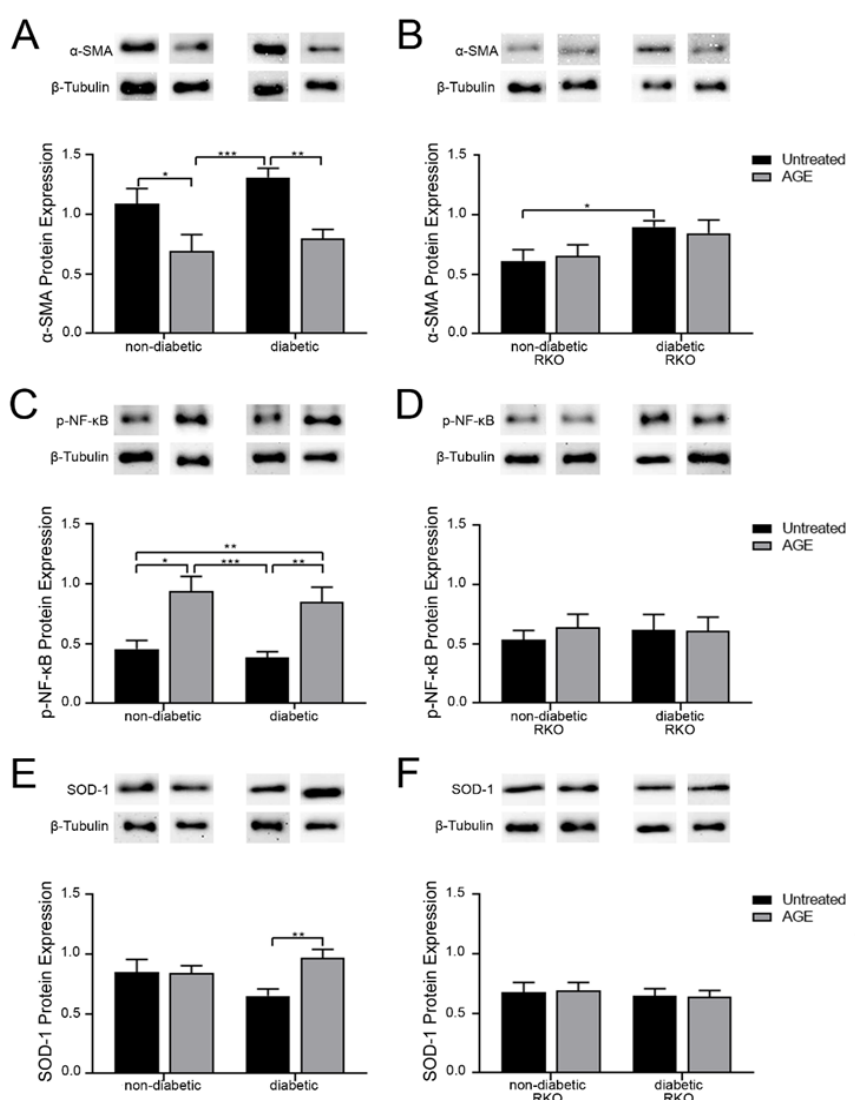
Figure 1. Diabetic conditions and exogenous AGEs caused a shift in expression of proteins associated with the RAGE signaling cascade. Cardiac fibroblasts were isolated from non-diabetic, diabetic, non-diabetic RKO, and diabetic RKO mice hearts and were either untreated or treated with exogenous AGEs (0.5 mg/mL). Protein expression was assessed for ( A,B ) α-SMA (42 kDA), ( C , D ) p-NF-κB (65 kDa), and ( E , F ) SOD-1 (23 kDa) in cardiac fibroblasts. Expression data were normalized to β-tubulin (55 kDa) protein expression and mean ± SEM are depicted on graph (n = 8–12). Representative western blot images are shown above graphs, but are not displayed as a continuous blot due to running order on the blot not aligning with graphical order of samples. However, original western blot images are available at DOI:10.6084/m9.figshare.12625409. A two-way ANOVA followed by a Fisher’s protected least significant difference post hoc determined significance. (* p < 0.05, ** p < 0.01, *** p < 0.001).